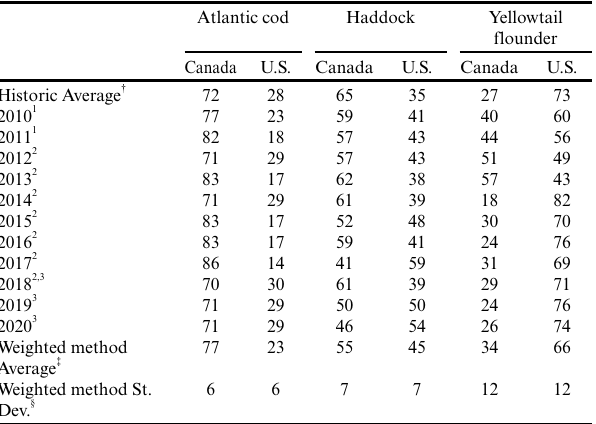
to match the DBEM 0.5º x 0.5º grid using the nearest neighbor Table 1 . Historical quota for Atlantic cod ( Gadus morhua ), method, and in some cases, bilinear interpolation (Cheung et al. haddock ( Melanogrammus aeglefinus ), and yellowtail flounder 2017). Finally, we used the model outputs for two scenarios ( Limanda ferruginea ) managed under the Gulf of Maine agreement for Canada and the United States. Values represent percentage of total quota that each country had. Atlantic cod Haddock Yellowtail flounder U.S. Canada